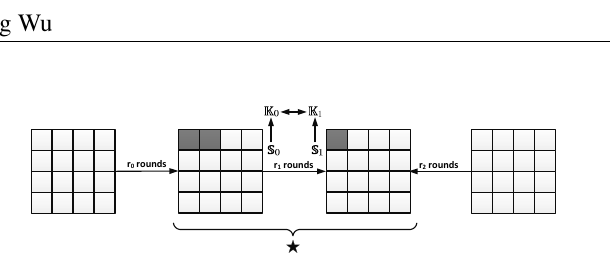
Figure 5: General model of meet-in-the-middle attack, where some messages in the middle rounds may verify a certain (cid:70) property used to perform the meet-in-the-middle